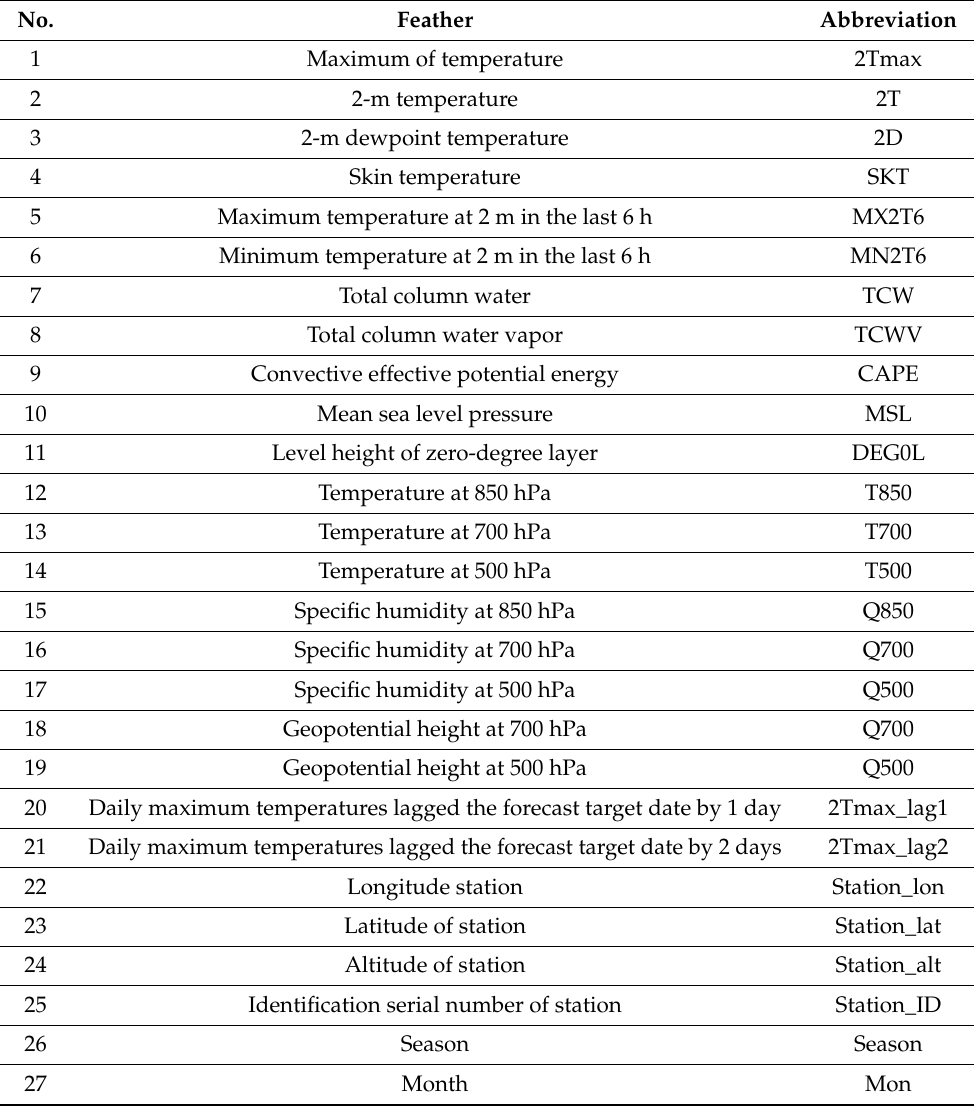
Table 2. The descriptions and abbreviations of all